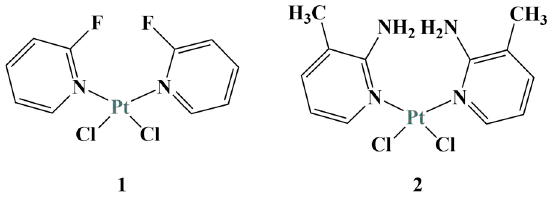
Figure 4. The pyridine-based complexes 1 and 2 described in [27].